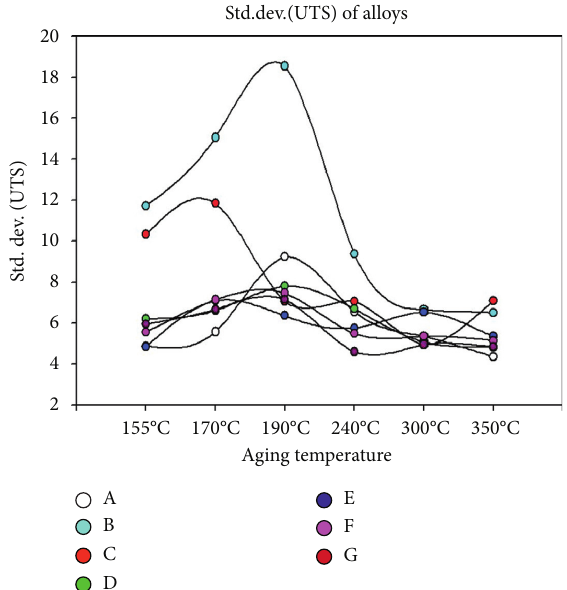
Figure 10: Mean standard deviation of the UTS values observed for the five alloys and two composites studied.